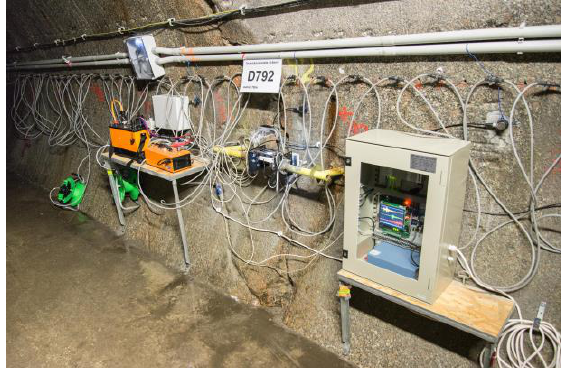
Figure 24. The system SGI 1. Locality Bedřichov, Jizerské hory. The field research for TA